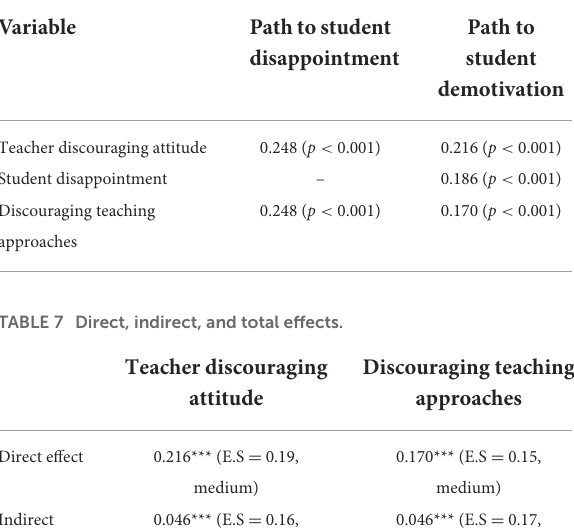
TABLE 6 The mediating role of student disappointment.